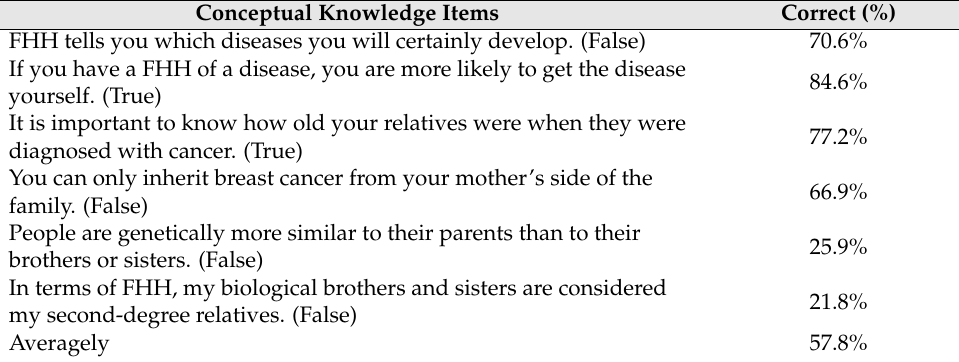
Table 2. FHH knowledge among college students in our